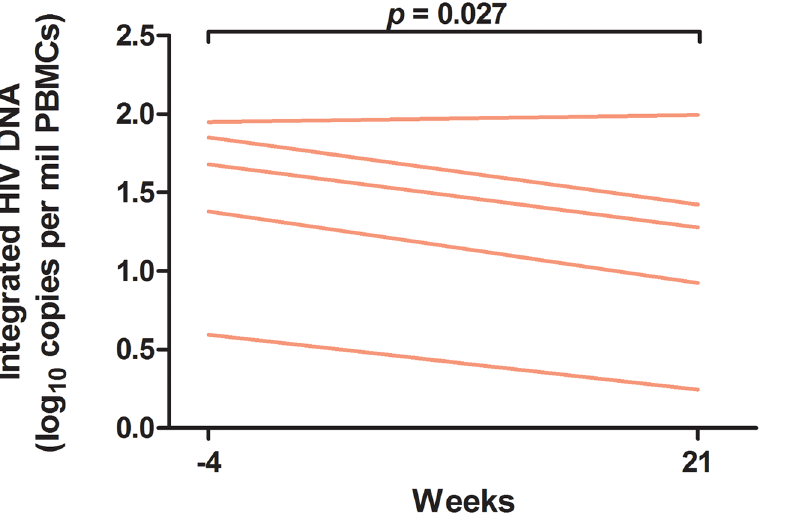
Figure 4. Change in integrated HIV DNA in peripheral blood. Change in integrated DNA levels before and after 21 weeks of antiretroviral therapy was measured using the paired t-test with bias-corrected and accelerated non-parametric confidence intervals. PBMCs=peripheral blood mononuclear cells.